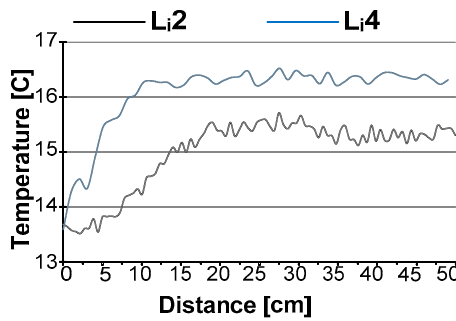
Figure 5. Temperature distribution along the lines Li1 and Li3.